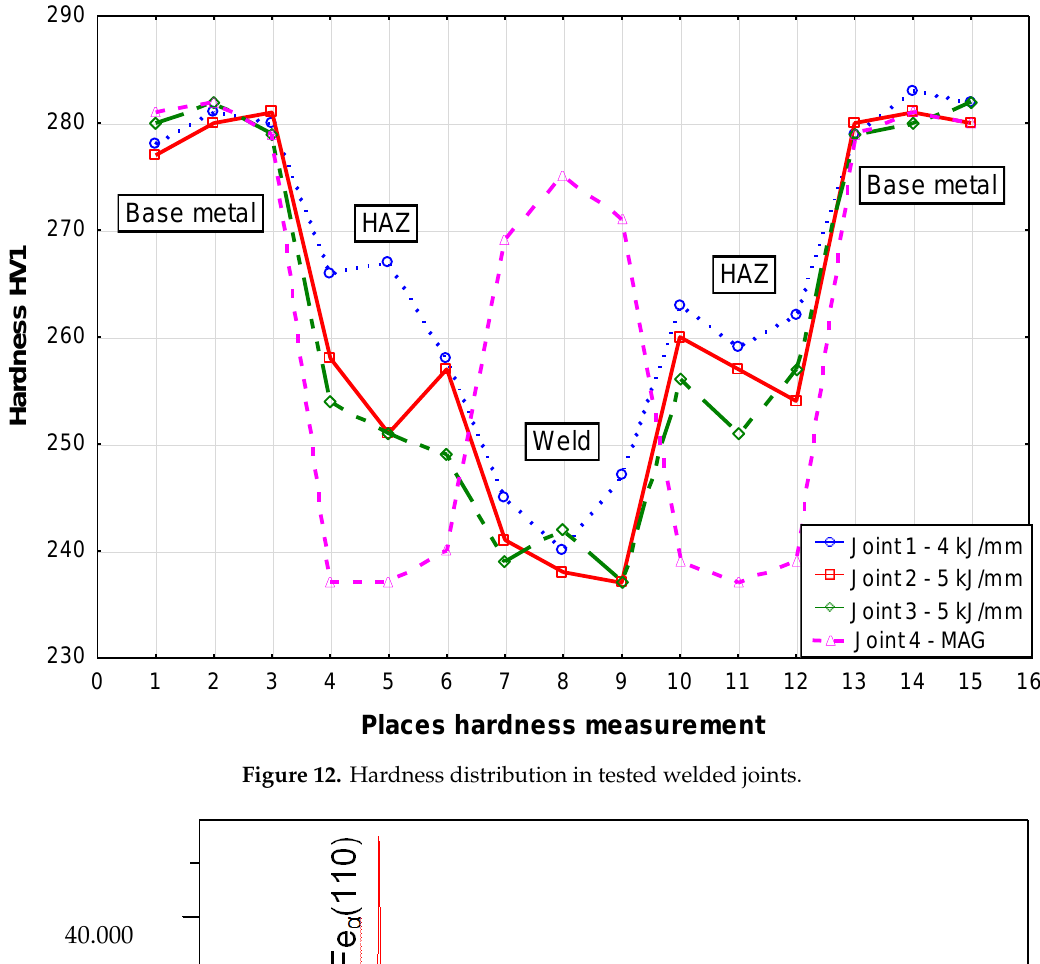
Figure 12. Hardness distribution in tested welded joints.